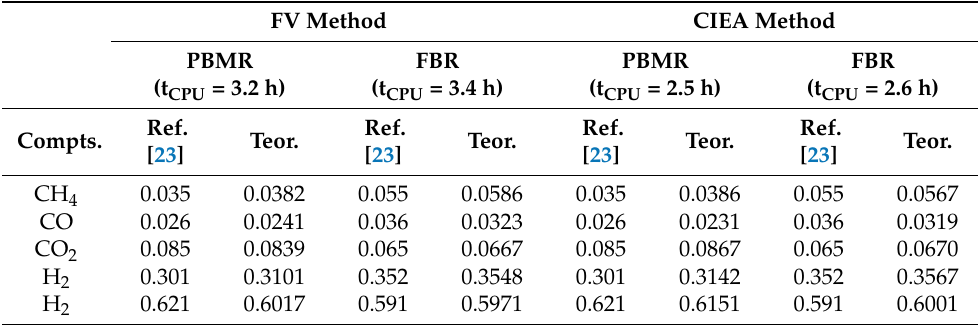
Table 5. Comparison of the results between the Finite Volume (FV) method and Coupled Integral Equation Approach (CIEA) method.